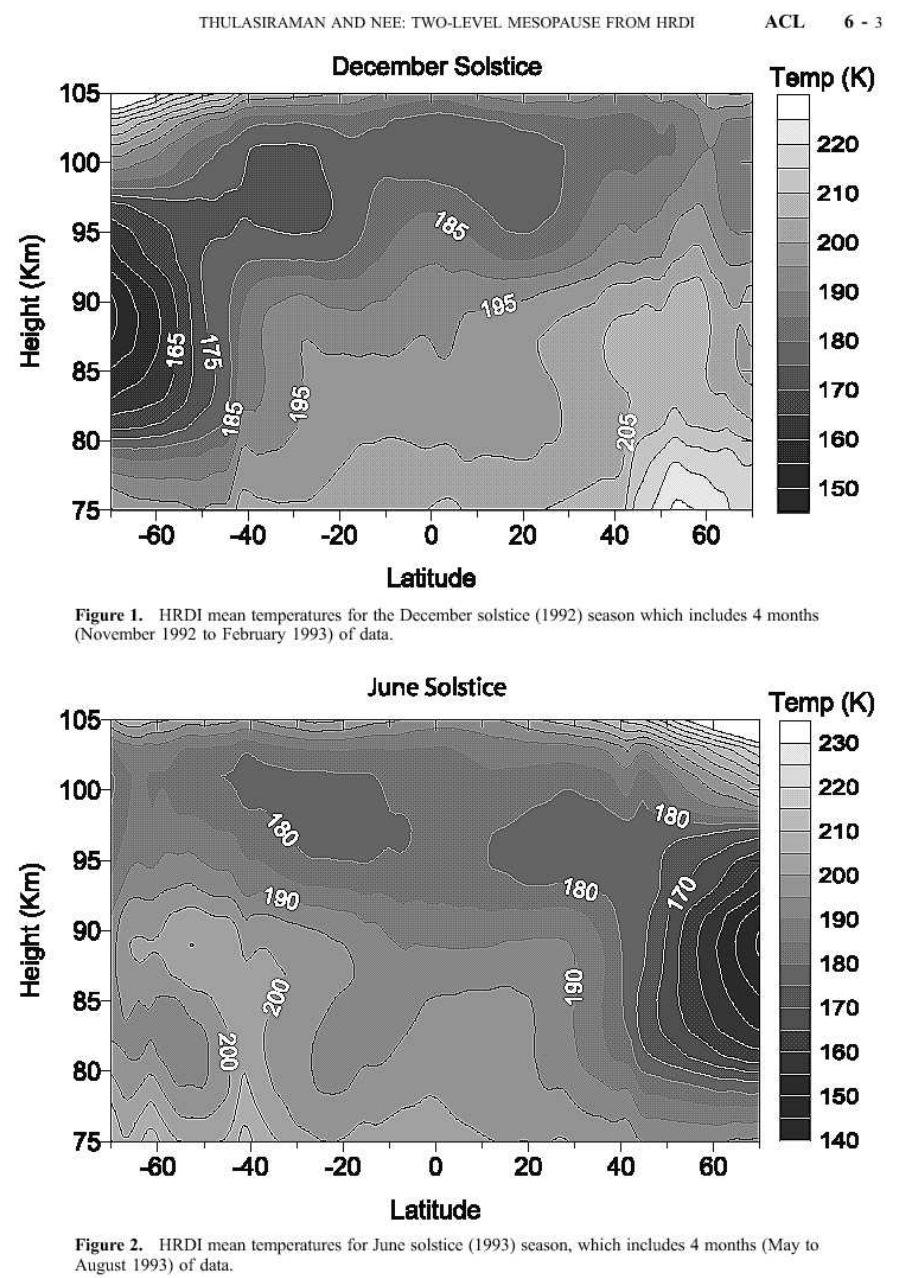
Fig. 1. Solstice temperature maps from the HRDI instrument on board the UARS satellite (after Thulasiraman and Nee,